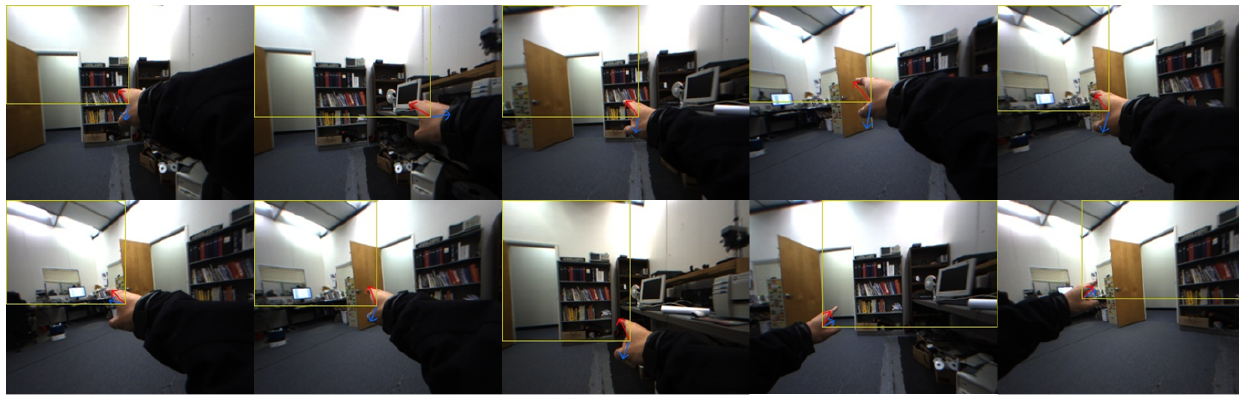
Figure 11. Results of finger pointing estimation (red arrow) with dynamic